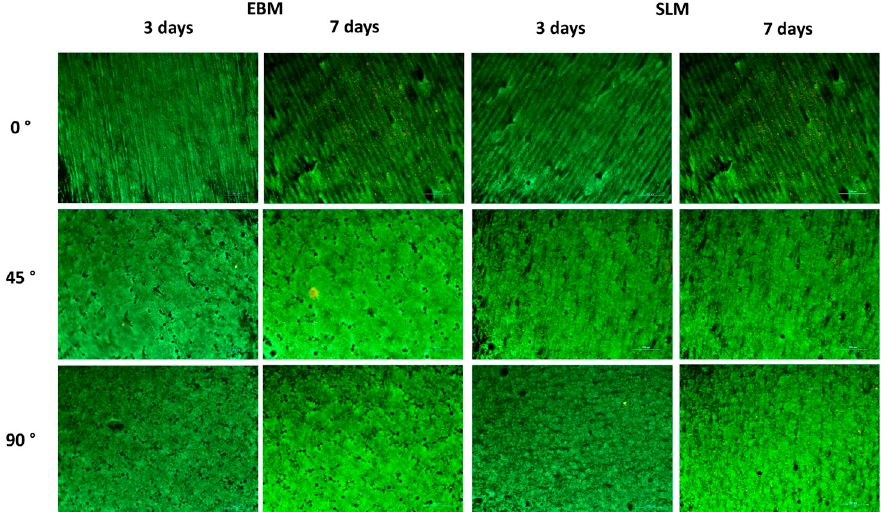
Figure 5. Live-dead staining of human osteoblasts on the EBM and SLM titanium specimens in the three different build orientations on day 3 and day 7 ( n = 3; green = living cells; red = dead cells; scale bar: 250 µm).